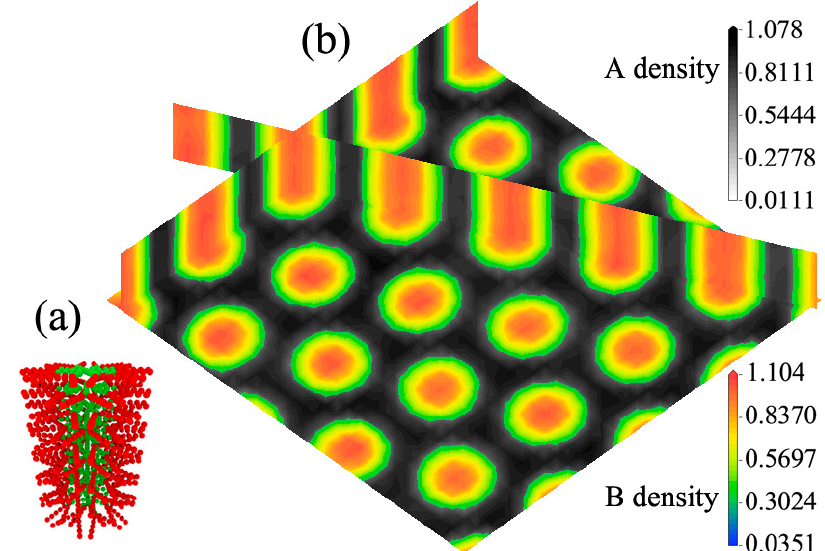
Figure 1. ( a ) Illustration of a cylindrical self-assembly structure formed by Y-shaped copolymer. The red particles are denoted A beads, and the green particles are denoted B beads. ( b ) One density slice along the X–Y plane, and two density slices through the cylindrical axes in two cylindrical arrays, where the latter two are vertical to the former one. The color mappings of A and B beads are in white-black and reverse rainbow, respectively.